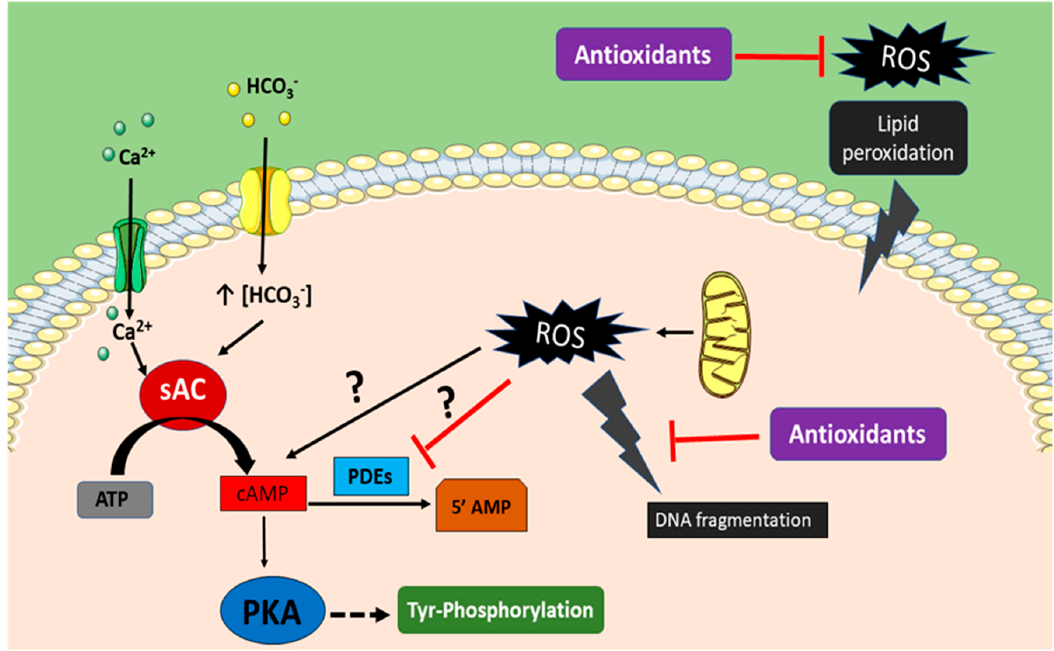
Figure 2. Proposed model of the bivalent role of reactive oxygen species (ROS) in sperm. (i) High levels of